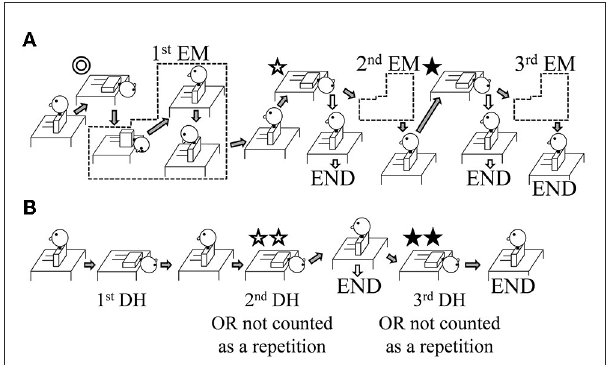
FIGURE1 Illustration of the study interventions. The interventions shown are for patients with right-sided benign paroxysmal positional vertigo (BPPV). In the case of left-sided BPPV, lateralized movements are performed on the opposite side. (A) Group A: The Epley maneuver (EM) was repeated a maximum of three times. After the first and second EM repetitions, the positional nystagmus was assessed using a Dix–Hallpike (DH) test (shown by I and ⋆ ). If positional nystagmus was absent on the affected side, the intervention ended (shown by the white arrows pointing to the word END). If positional nystagmus was still present, a further EM repetition was performed (shown by the gray arrows). (B) Group B: The repeated DH test was performed with up to three repetitions. If the positional nystagmus on the affected side was found to be absent at the second DH test (shown by II ), the intervention ended (shown by the white arrows pointing to the word END); in this case, the number of repetitions was recorded as one, i.e., the movement shown by II was not counted. If positional nystagmus was still present, a further DH test was performed (shown by the gray arrows). For the third DH test (shown by ⋆⋆ ), if positional nystagmus was absent, the number of repetitions was recorded as two, i.e., the movement shown by ⋆⋆ was not counted; if positional nystagmus was present, the number of repetitions was recorded as